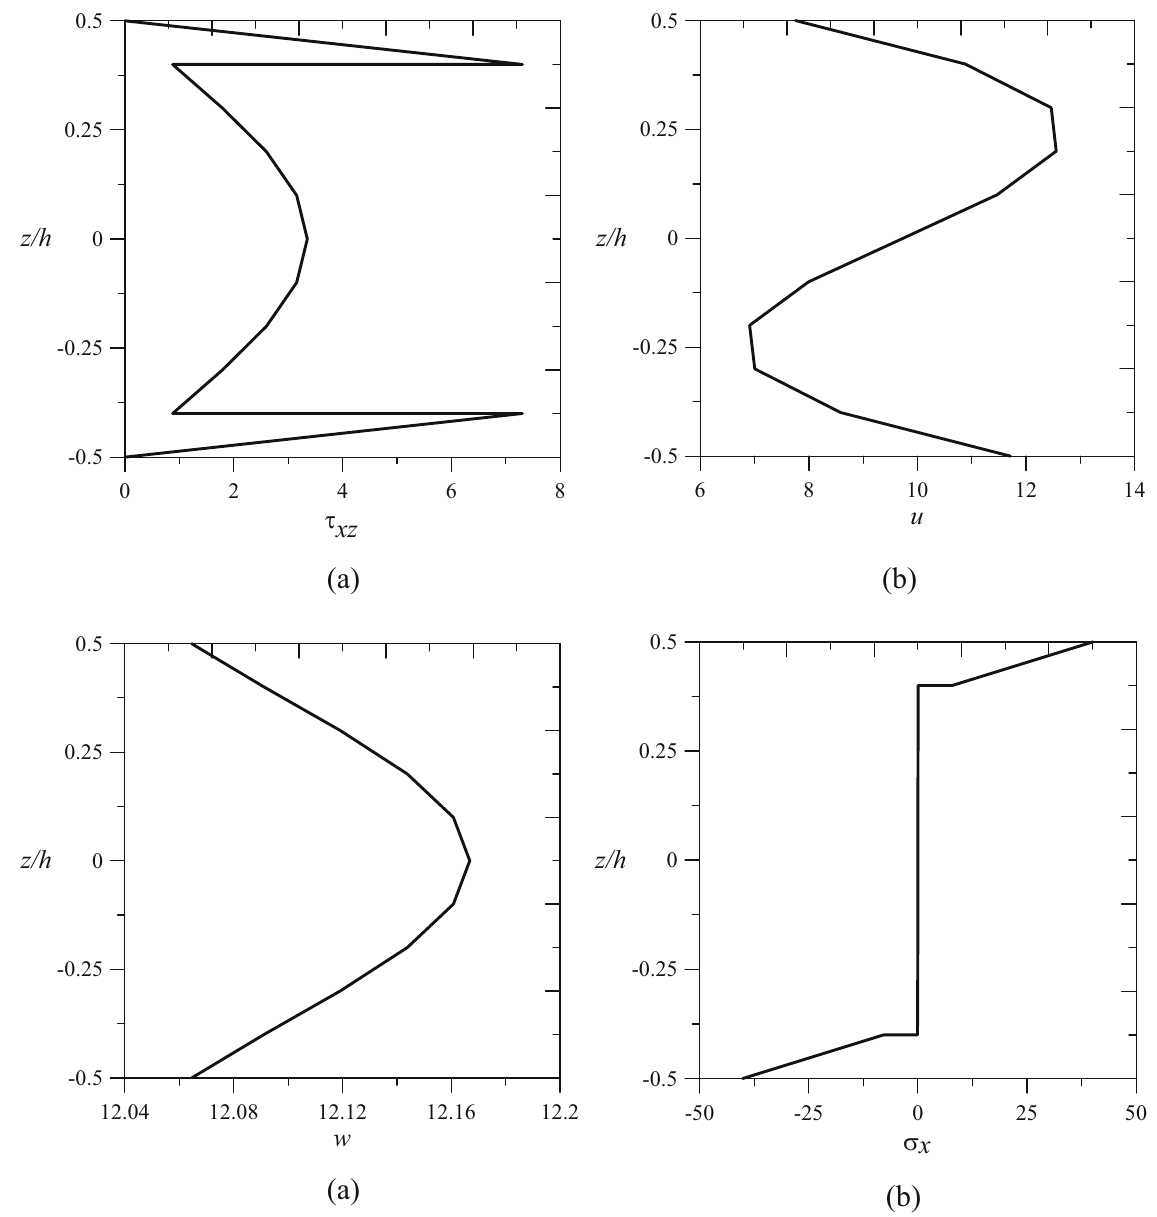
Figure 4: Variation through the thickness for transverse shear stresses ( a ) , axial displacements ( b ) , transverse displacements ( c ) , and axial bending stresses ( d ) for sandwich ( 0°/Core/0° ) arches subjected to UDL ( R / h = 5; L / h = 4 )